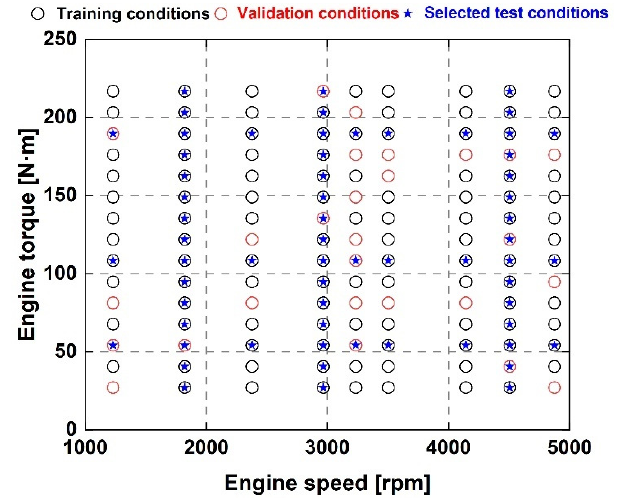
Figure 3. Training, validation, and test data for machine learning approaches.